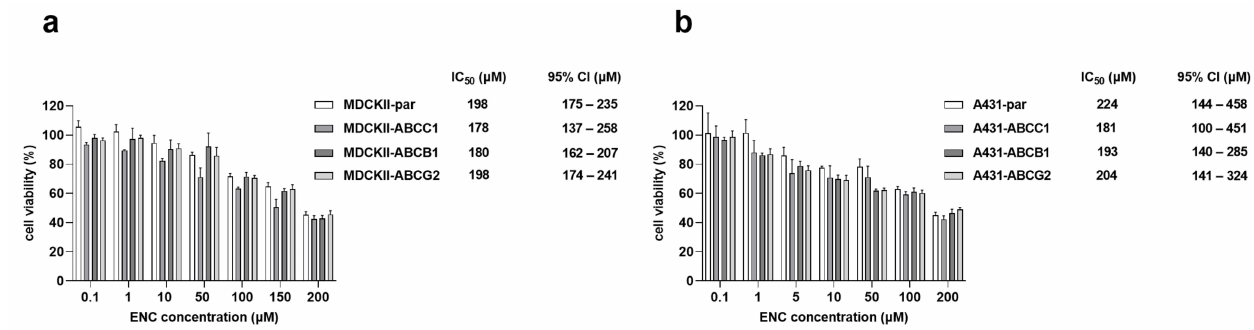
Figure 5. Effect of ABC transporter expression on the reactivity of ( a ) MDCKII and ( b ) A431 cell lines to encorafenib’s antiproliferative activity. Encorafenib was added to the tested cellular models for a 48-h exposure. MTT assay was used for the determination of cell viability. After calculating IC 50 values, a two-tailed unpaired t -test was used for examining the possible significant differences between IC 50 from parental cell line with IC 50 from each of the transporter-overexpressing cell lines. As a result, no statistical differences were found in all the comparisons. Each experiment was performed 3 times independently. ENC, encorafenib; error bar, standard